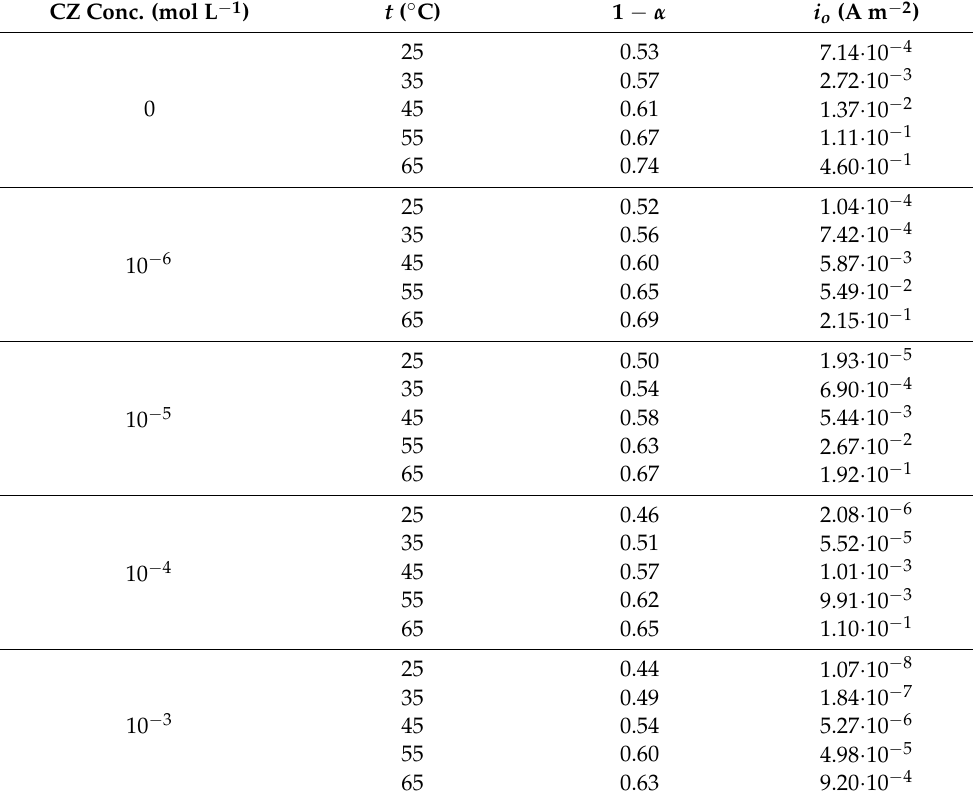
Table 2. Kinetic parameters for nickel deposition from 5 g L − 1 Ni 2+ without and with different concentrations of CZ, in 25–65 ◦ C temperature